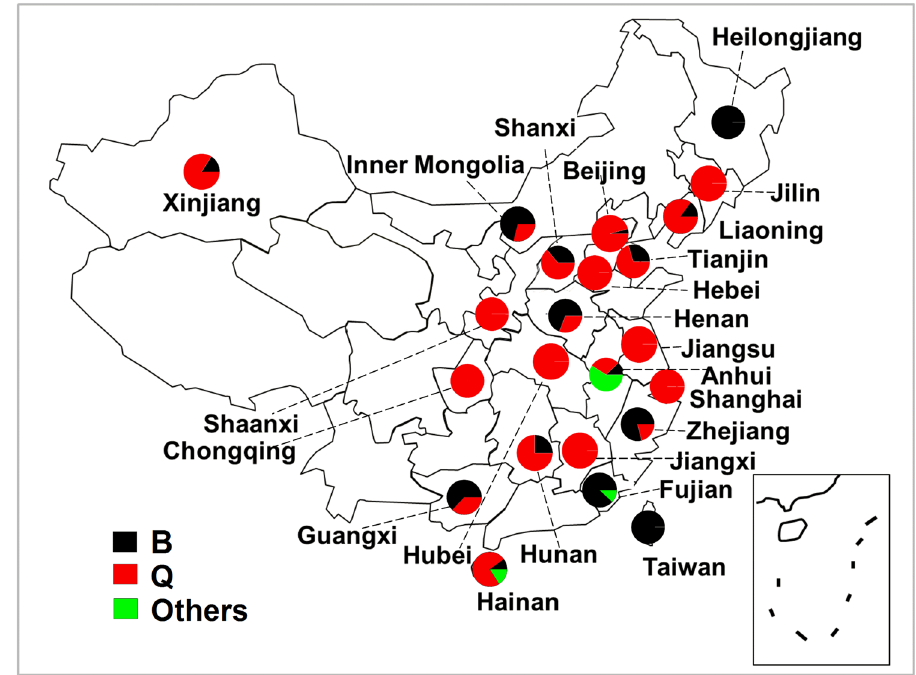
Figure 1. Distribution of Bemisia tabaci species in China in 2011. Circles denote proportion of B . tabaci B (black), Q (red) and other species (green) in collections. This China map was created using Microsoft PowerPoint (version 2010) by author Hui-Peng Pan.